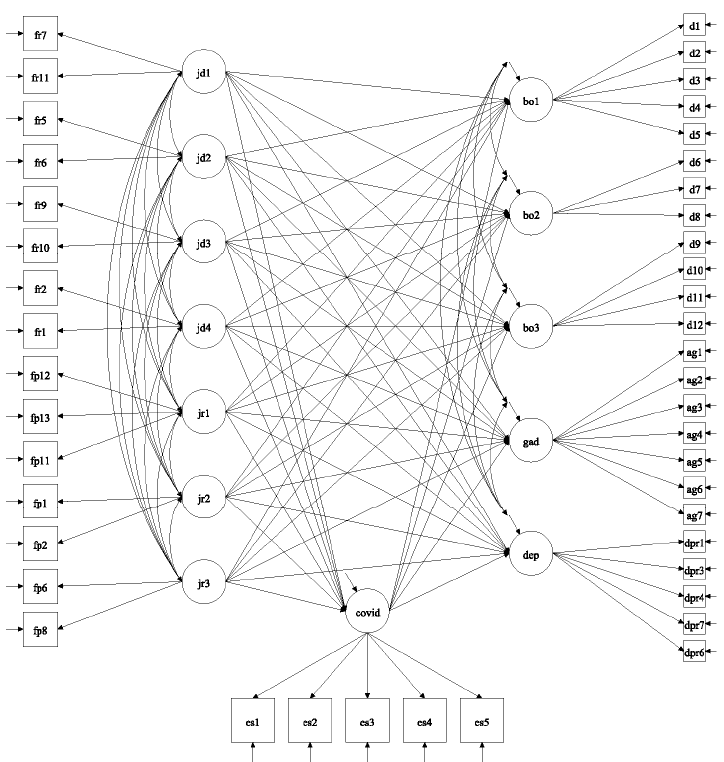
Figure 1. Structural equation path model of job demands and resource on distress outcomes with COVID-19 traumatic stress as mediator. Note: Latent constructs are shown in ellipses, observable variables are shown in rectangles, measurement error terms are not shown. fr1 to fr11 = job demands items; fp1 to fp13 = job resources items; jd1= workload; jd2 = confinement; jd3 = loss; jd4 = virus exposure; jr1 = self-efficacy; jr2 = momentary recuperation; jr3 = meaning making; covid = COVID-19 traumatic stress; bo1 = emotional exhaustion; bo2 = depersonalisation; bo3 = achievement dissatisfaction; gad = generalised anxiety; dep = depression; cs1 to cs5 = COVID-19 traumatic stress items; d1 to d12 = burnout items; ag1 to ag7 = generalised anxiety items; dpr1 to dpr6 = depression items. Double-headed arrows represent covariances. Single arrows represent direct effects.